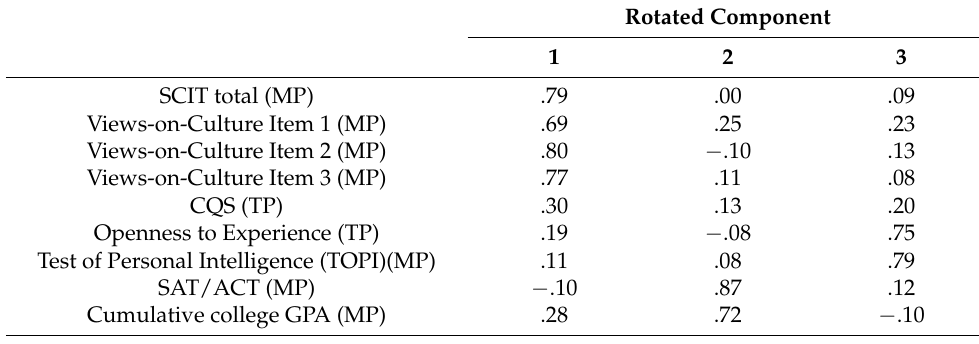
Table 9. Rotated Principal Components Matrix a : SCIT, VC, CQS, OE, TOPI, SAT/ACT, and GPA.